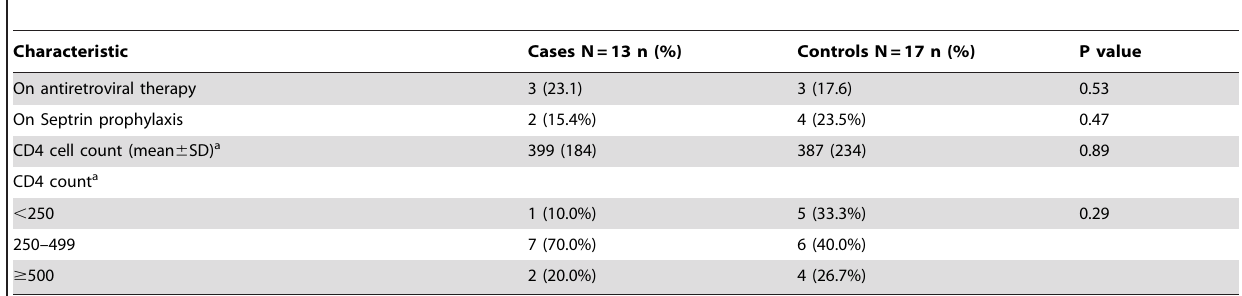
Table 2. Selected treatment characteristics of HIV-positive participants in case-control study of risk factors for hospitalized influenza, Bondo District, Kenya, 2007-9.